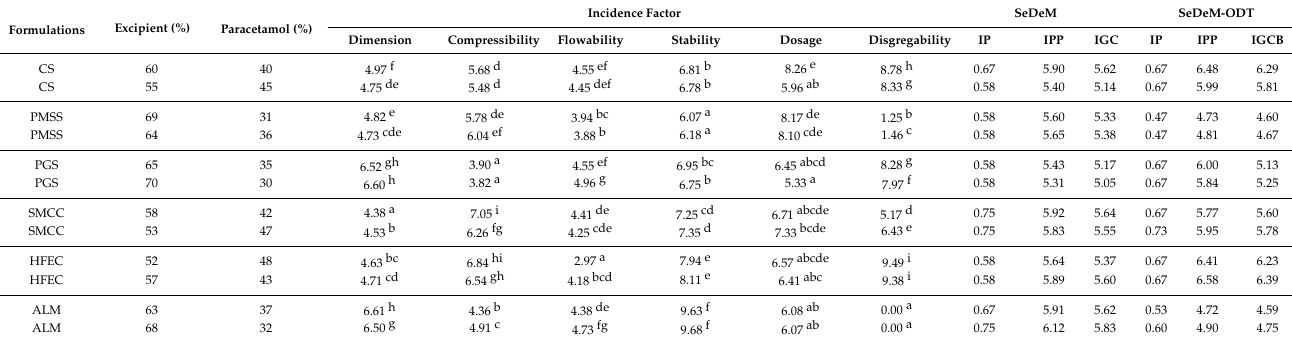
Figure 2. SeDeM-ODT diagrams of paracetamol formulations containing different types and ratios of directly compressed excipients. Table 4. Incidence factor and parametric index values of paracetamol tablets formulated with various types and ratios of